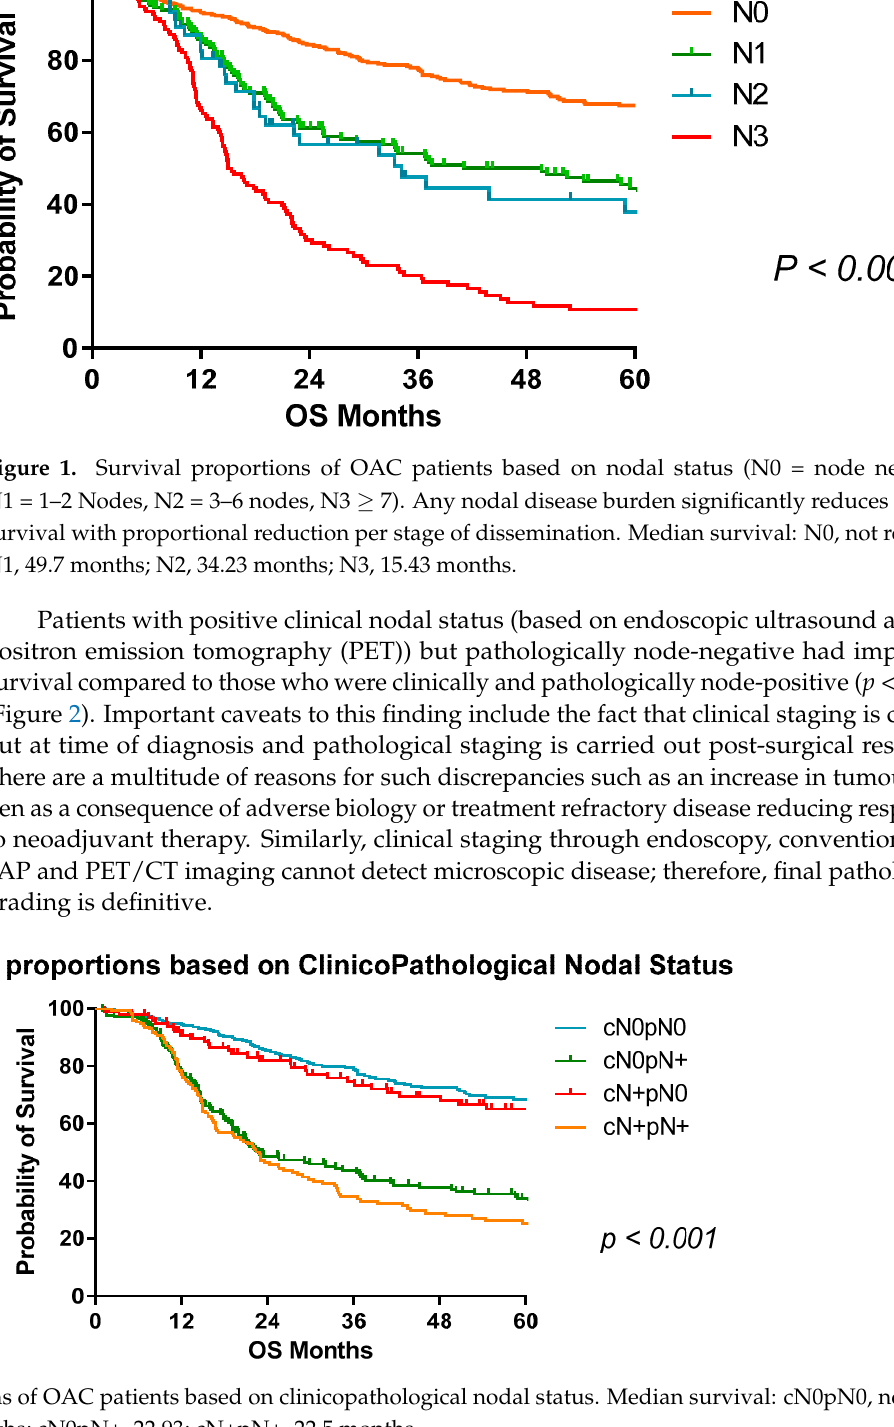
Table 4. Overall survival of OAC patients based on clinicopathological nodal status.